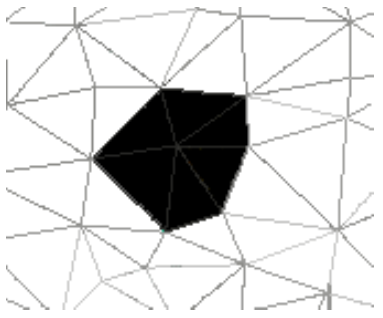
Figure 10. A triangular mesh collection using variational points as the vertex.